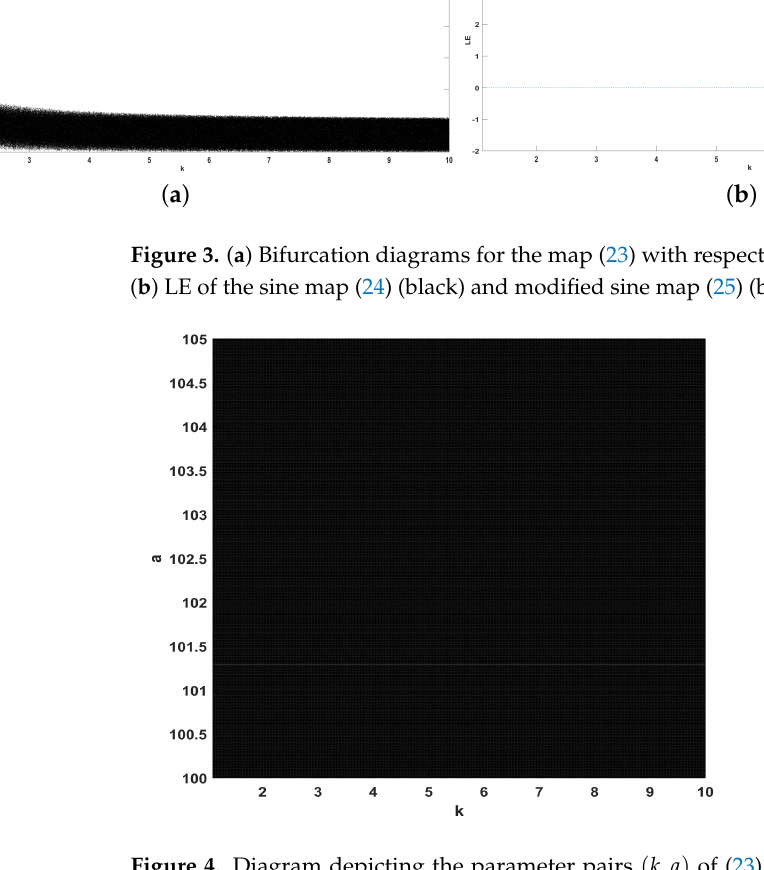
Figure 4. Diagram depicting the parameter pairs ( k , a ) of (23) that yield chaotic behavior. Black regions depict chaos, while white regions are non-chaotic. The lack of white regions indicates robust chaotic behavior. The simulation stepsize for each parameter range was set to